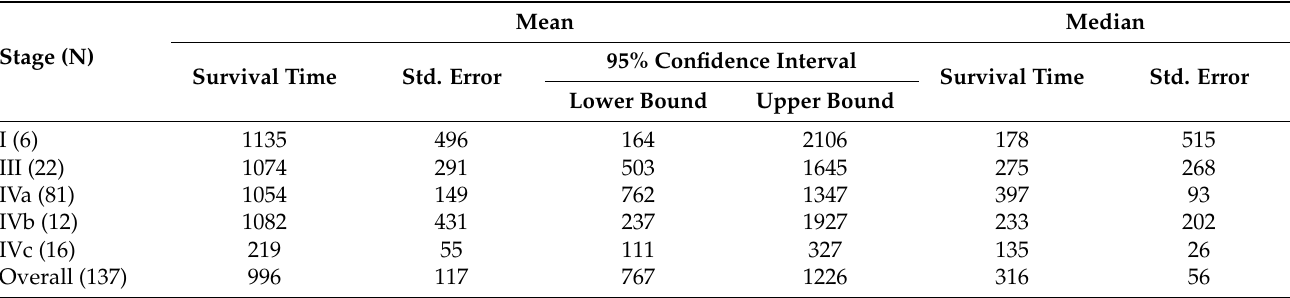
Figure 1. Kaplan–Meier curve of the cumulative survival for different cancer stages. The mean survival time was 996 days (Table 4). Table 4. Means and Medians for survival time (days) by stage of cancer.